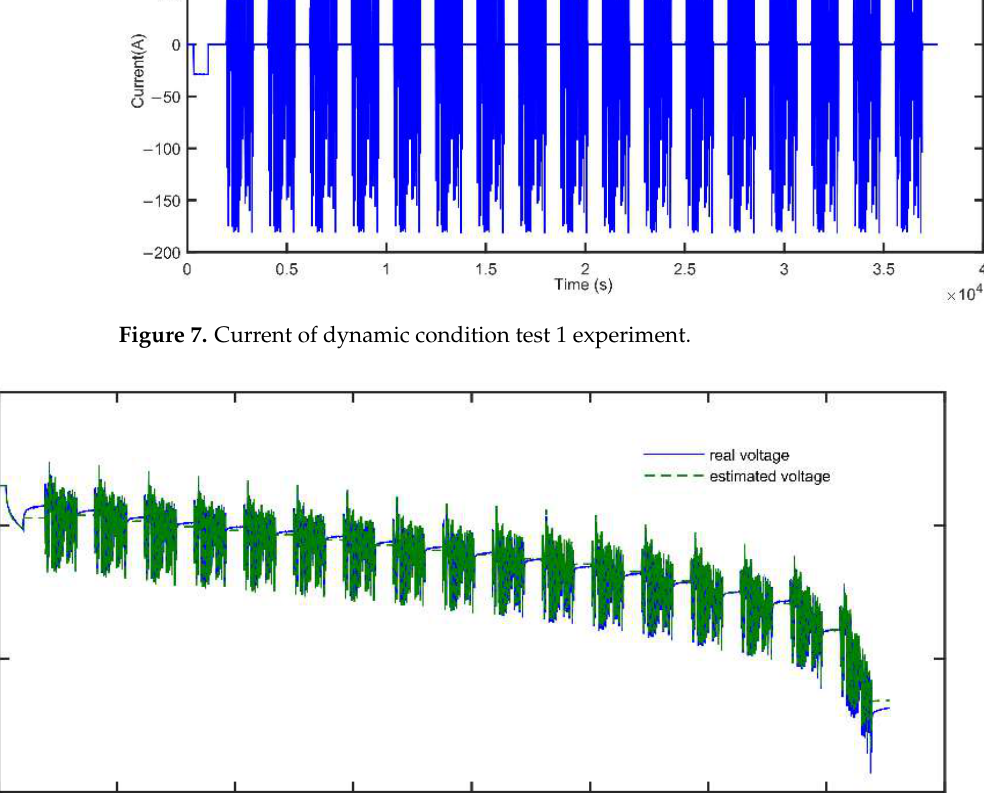
Figure 9. Comparison of real value and estimated value of experimental terminal voltage in dy- namic condition test 1. Figure 10. Voltage estimation error of experiment terminal in dynamic condition test 1. The results of estimating SOC using the proposed RBF neural network non-linear observer and EKF method are shown in Figure 11. It can be seen that the proposed RBF